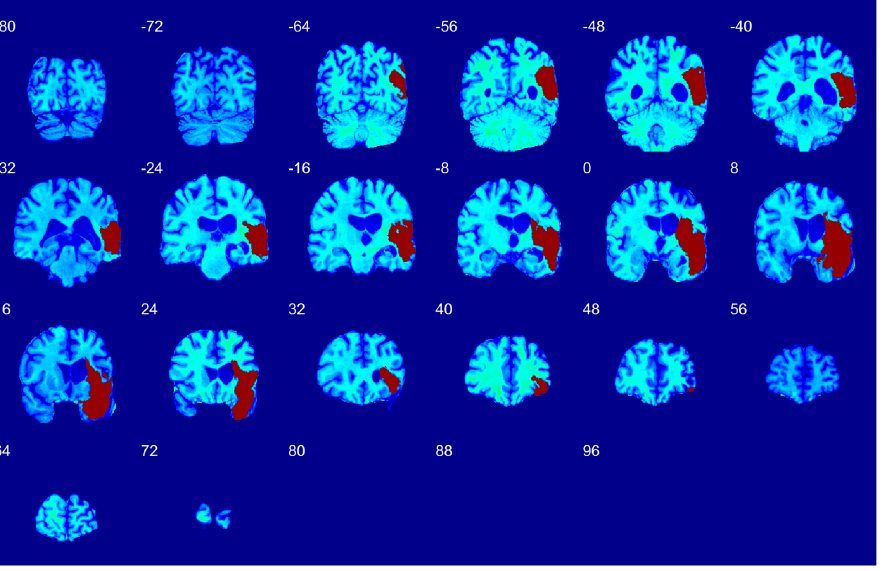
Figure 5. Sagittal sections showing automatic segmentation of left MCA stroke.